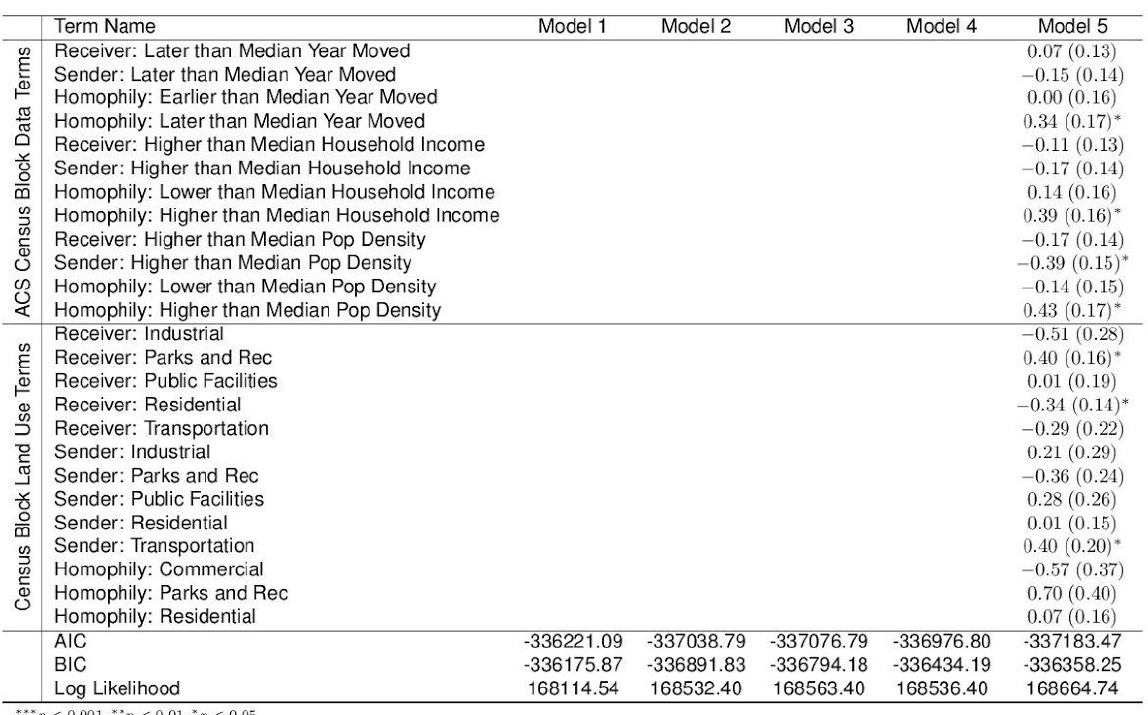
Table A3.4: New York City Models Part